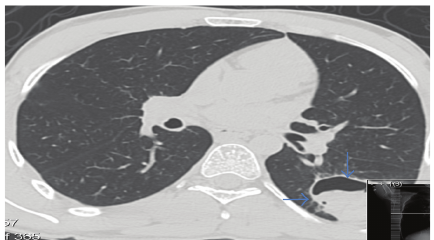
Figure 3: Chest CT: cavitation measuring 5.6 cm in the superior segment of the left lower lobe that contained soft tissue density (blue